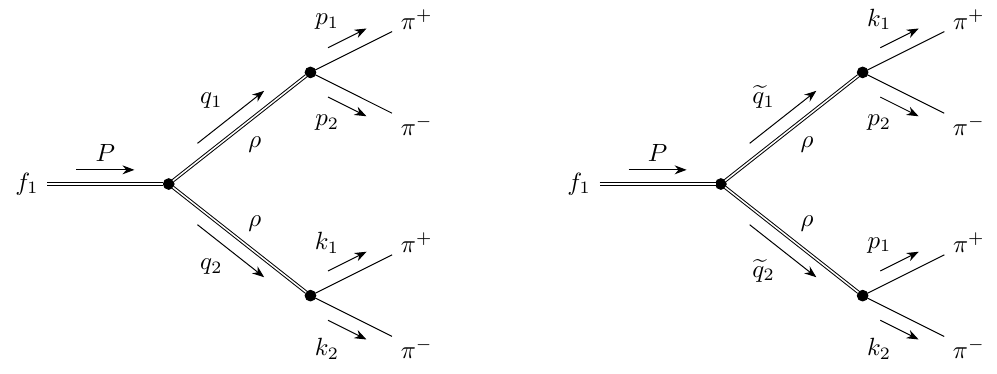
Figure 4 . Feynman diagrams for f 1 → π + π − π + π − via two ρ mesons. Since the two π + and π − are respectively indistinguishable, there exist two contributions ( left and right